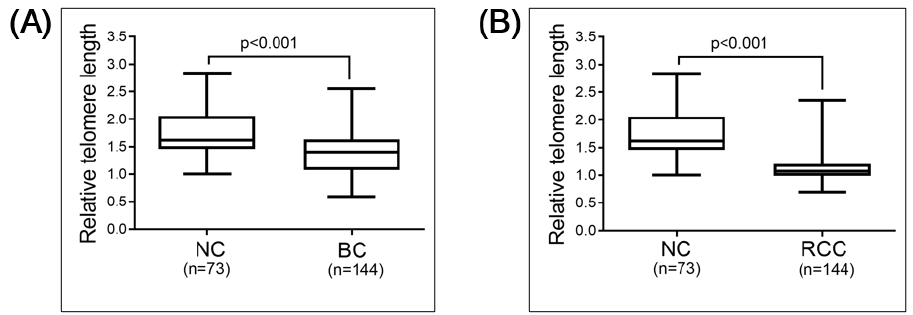
Figure 2. Comparison of RTL: ( A ) normal control (NC) group ( n = 73) versus bladder cancer (BC) group ( n = 144); ( B ) NC group ( n = 73) versus renal cell carcinoma (RCC) group ( n = 144). Comparisons were performed using Mann–Whitney test.